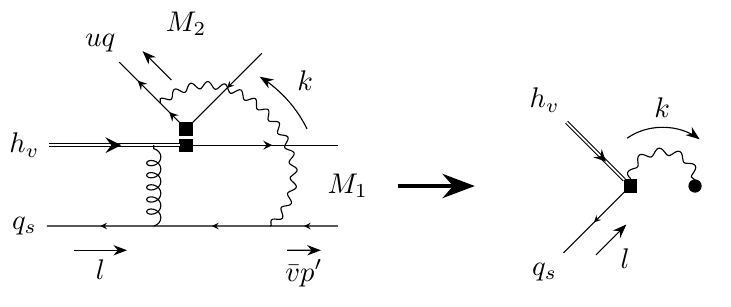
Figure 2 . Example of a full theory (QCD × QED) diagram giving rise to diagram a) of figure 1 in the effective theory (HQET × SCET II ). In the full theory, a soft photon couples to the collinear and anti-collinear quarks of the two outgoing mesons, labeled by M 1 and M 2 . The hard-collinear gluon (curly line) carries momentum ‘ − k − ¯ vp 0 , with p 0 aligned to the light-like vector n − . The hard- collinear gluon propagator at leading power in the effective theory is proportional to the inverse of ω = n − ( ‘ − k ) = ω 0 − n − k , resulting in the standard 1 /ω inverse moment. Since the light-cone momentum of the soft photon (wavy line) can be of order n − k ∼ O ( un − · q ) ∼ O ( m b → ∞ ) we conclude that even for ω 0 > 0 a contribution with ω = ω 0 − n − k < 0 will be